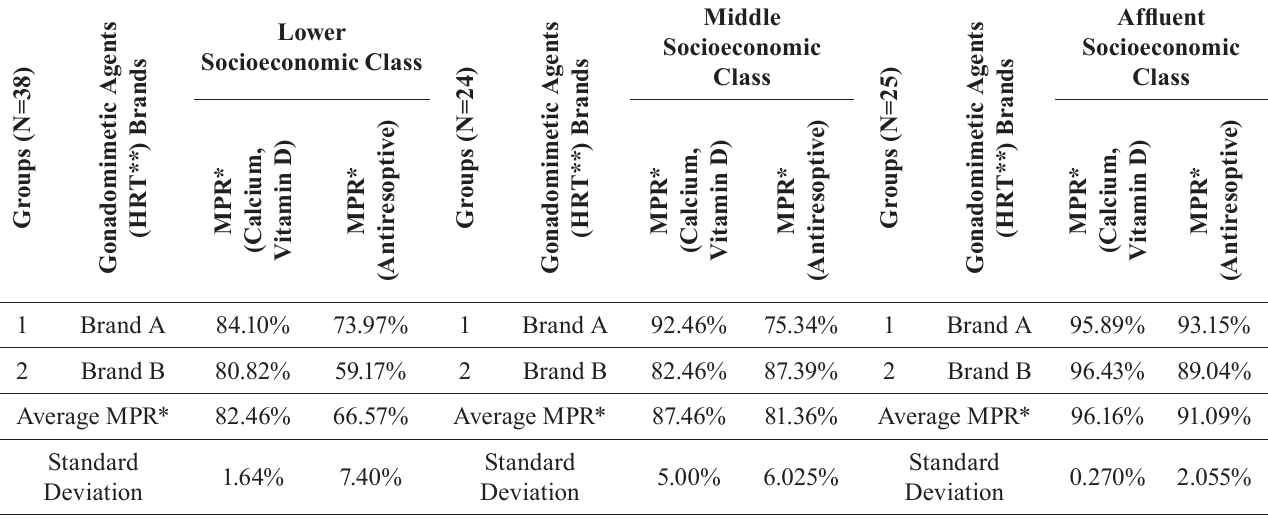
TABLE IV - MPR of Gonadomimetics Brands, Calcium, Vitamin D in different Socioeconomic Classes